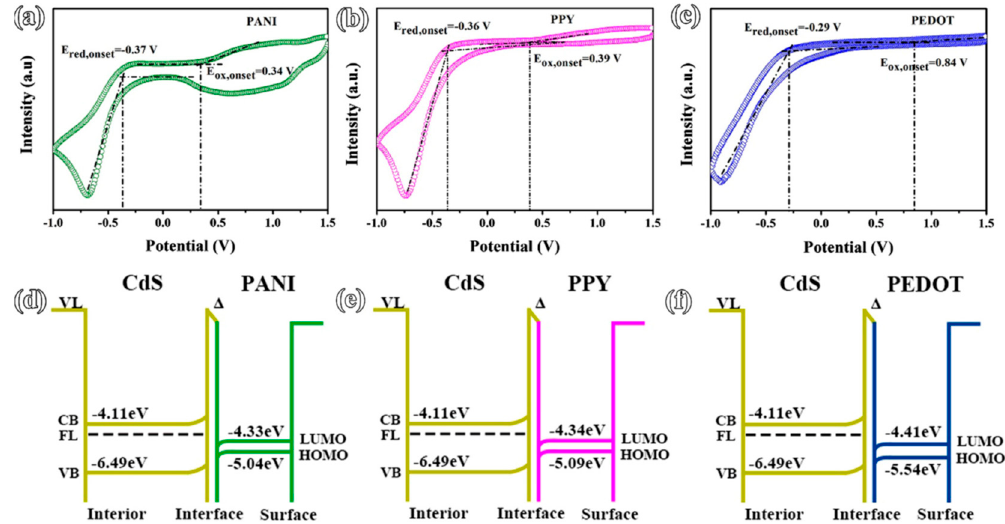
Figure 7. The CV curves ( a – c ) and band structures ( d – f ) of PANI@CdS, PPY@CdS, and PEDOT@CdS core-shell nanorods [49].